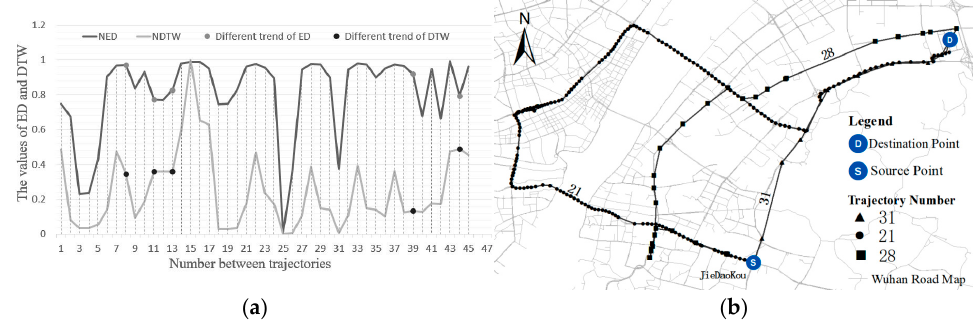
Figure 3. Geographic distribution of four SD pairs of experimental data.